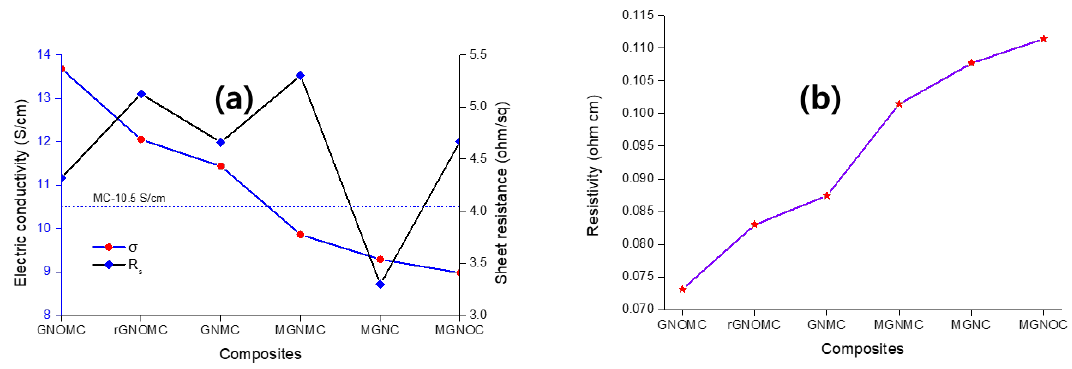
Figure 6. ( a ) Electric conductivity and sheet resistance of the composites and ( b ) resistivity of the composites (R s : sheet resistance; σ : electric conductivity).